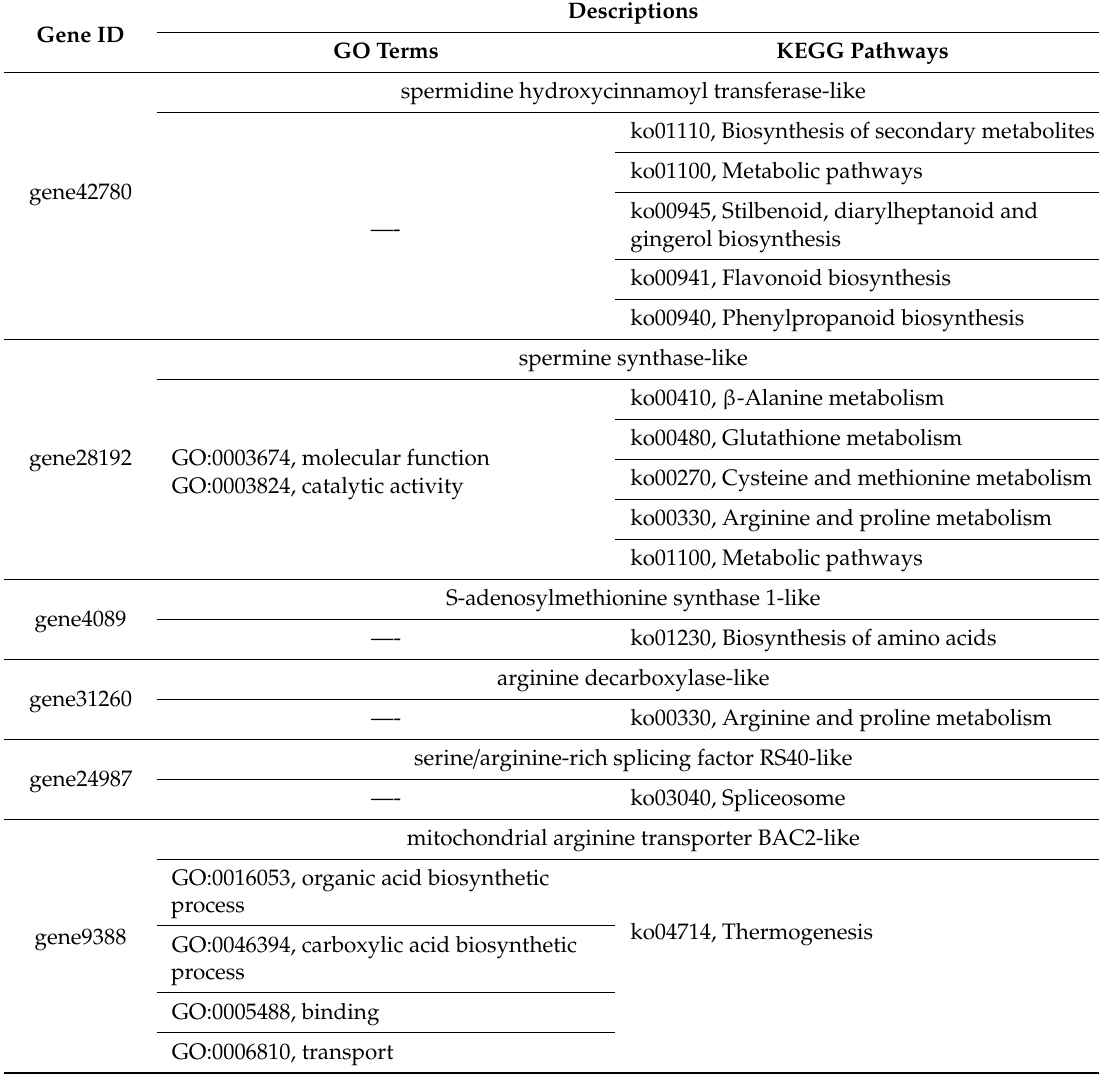
Table 4. Six genes closely related to polyamine biosynthesis /